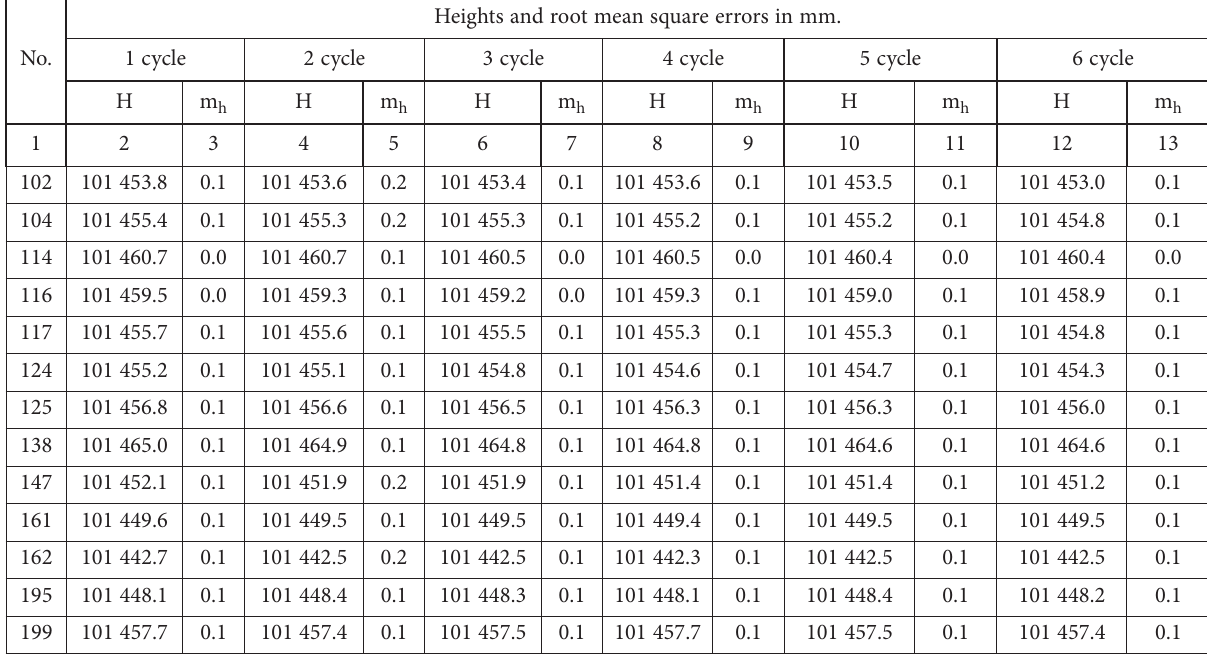
Table 1. Heights of sedimentary marks, laid on the first floor of the “Shuvar” mall, and their standard squares errors (1–6 cycles) Heights and root mean square errors in No.